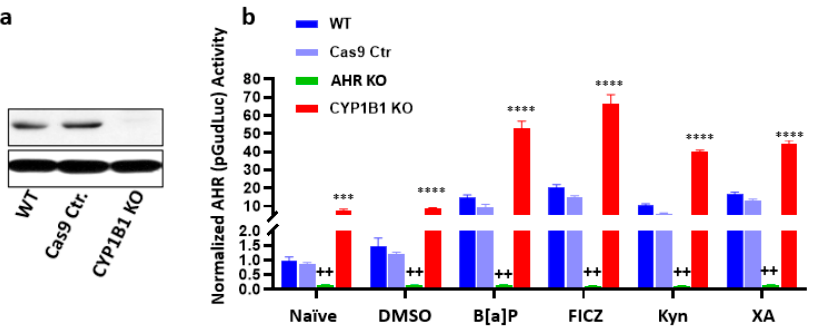
Figure 5. AHR Knockout Reduces and CYP1B1 Knockout Enhances Baseline and Ligand-induced AHR Activity. The AHR or CYP1B1 was deleted from triple negative, inflammatory human breast cancer cells [162]. ( a ) Western blotting showing the absence of detectable CYP1B1. (See Figure 3 for AHR knockout western blots). ( b ) CMV-driven GFP-normalized, AHR-driven pGudLuc reporter activity was assayed in wildtype, Cas9 control, AHR knockout, or CYP1B1 knockout SUM149 cells treated for 24 hours with 0.1% DMSO (vehicle), 10 uM B[a]P, 0.5 uM FICZ, 100 uM kynurenine (Kyn), or 100 uM xanthurenic acid (XA). Data are presented as normalized means + SE. from a minimum of three experiments. ++ p < 0.01 relative to similarly treated Cas9 control. *** p < 0.001 relative to similarly treated Cas9 control. **** p < 0.0001 relative to similarly treated Cas9 control.